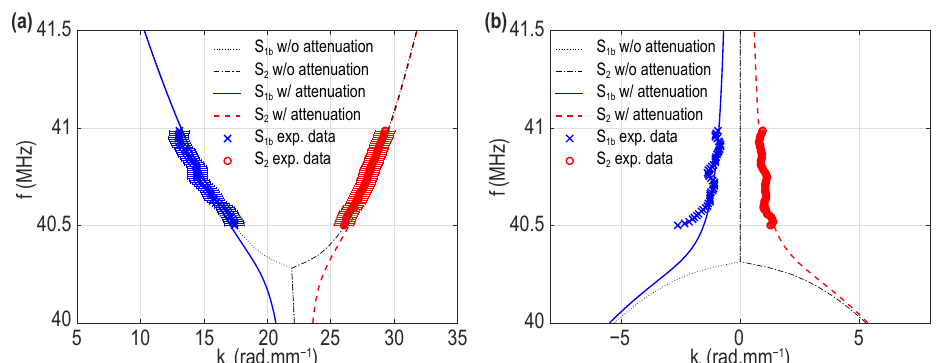
Figure 4. Dispersion curves in ( a ) the plane ( k r , f ) and ( b ) the plane ( k i , f ). The lines stand for the theoretical dispersion curves with (w/) or without (w/o) taking into account the attenuation. The symbols stands for the experimental data. In ( a ), the error bars of the experimental measurements in the recovery of the real part of the wavenumber is depicted by horizontal